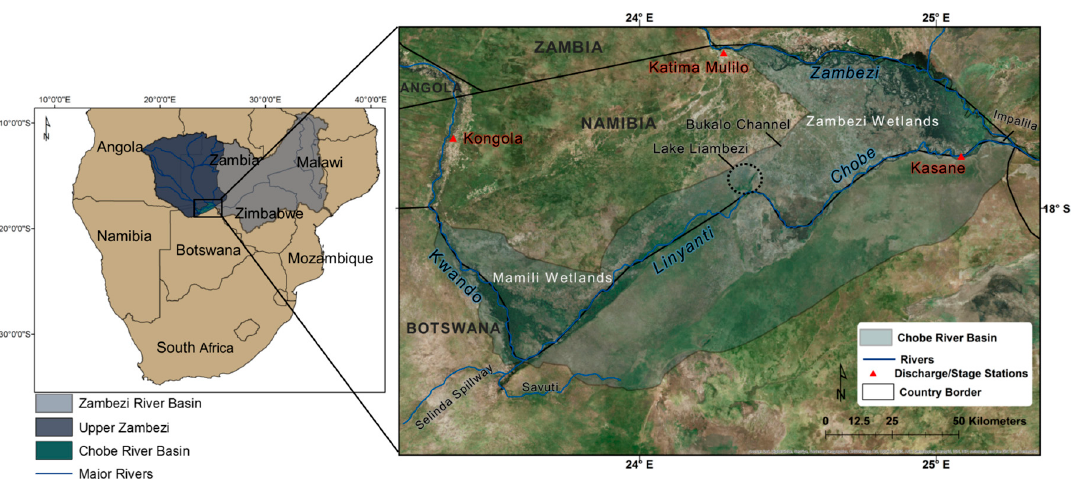
Figure 1. Study area showing the Chobe River Basin in Namibia and Botswana. Also shown are the rivers that provide water to the region: the Zambezi River, the Linyanti and Chobe Rivers in the of the basin, and the Kwando River. center of the basin, and the Kwando River.